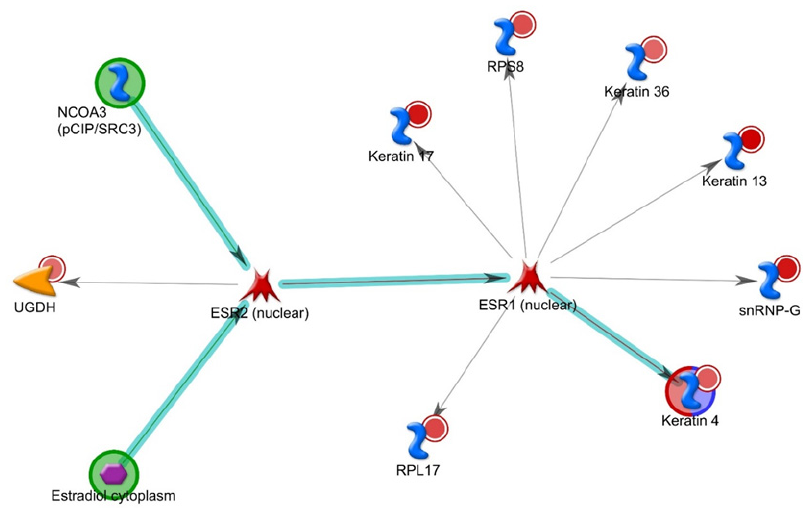
Figure 3. Metacore network analysis identifies eight of the top 21 interactors within the same estrogen receptor protein receptor protein network.